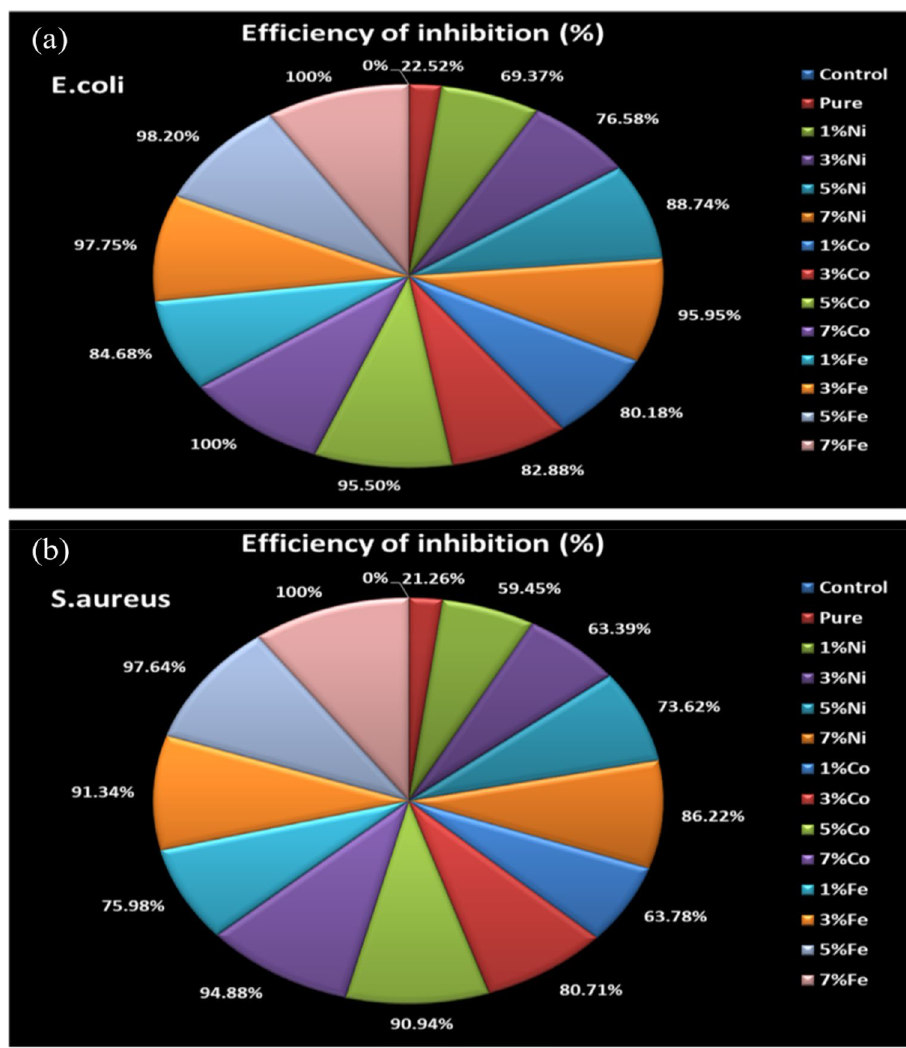
Figure 21. The efficiency of inhibition of nanoparticles at 80 μg/ml against ( a ) E. coli and ( b ) S.